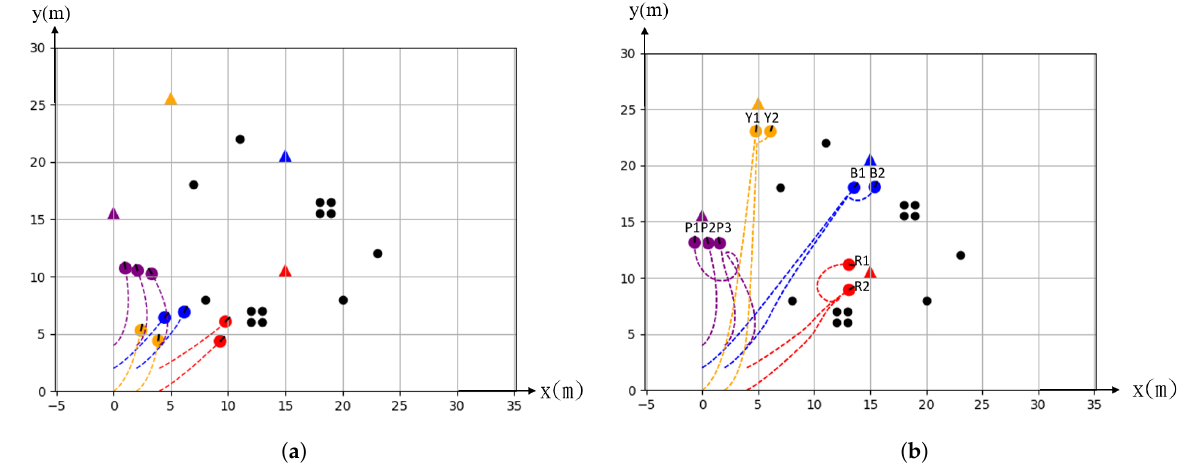
Figure 6. Simulation of static multi target. ( a ) Original toward to the target. ( b ) Finally stop at the target.